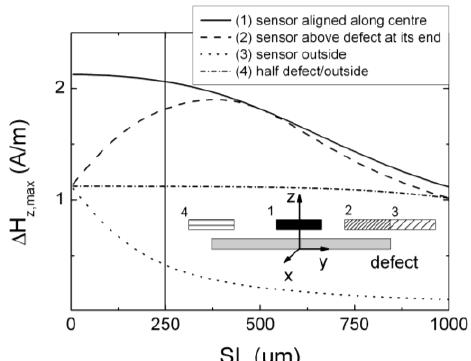
Figure 8. Sensor scanning across the crack with a length of 500 µm along x -direction ( BL = 250 µm, LO = 150 µm and SH = 50 µm). The sensor is aligned parallel to the defect. The scheme shows the different sensor positions above the defect, labelled 1, 2, 3, and 4. Details are described in the